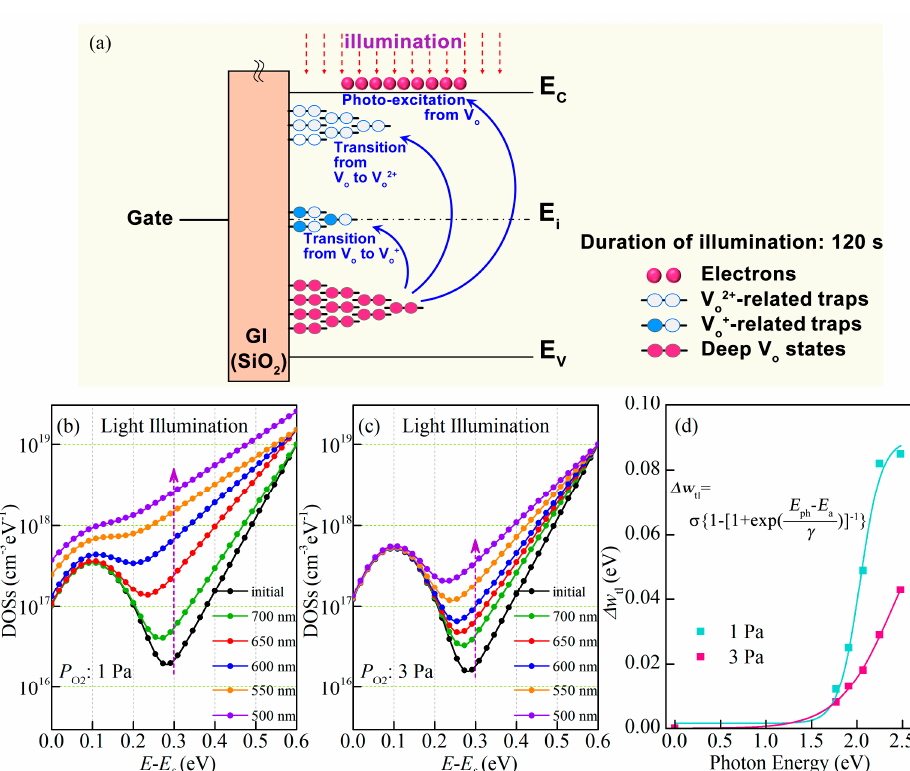
Figure 7. ( a ) Schematic diagram of the V o -related defect generation process for a-IGZO TFTs under short-wavelength light. Calculated DOSs as a function of monochromatic light illumination for a-IGZO TFTs fabricated with different Po 2 values: ( b ) 1 Pa and ( c ) 3 Pa; ( d ) the shift of w tl for a-IGZO TFTs fabricated with Po 2 values of 1 Pa and 3 Pa.